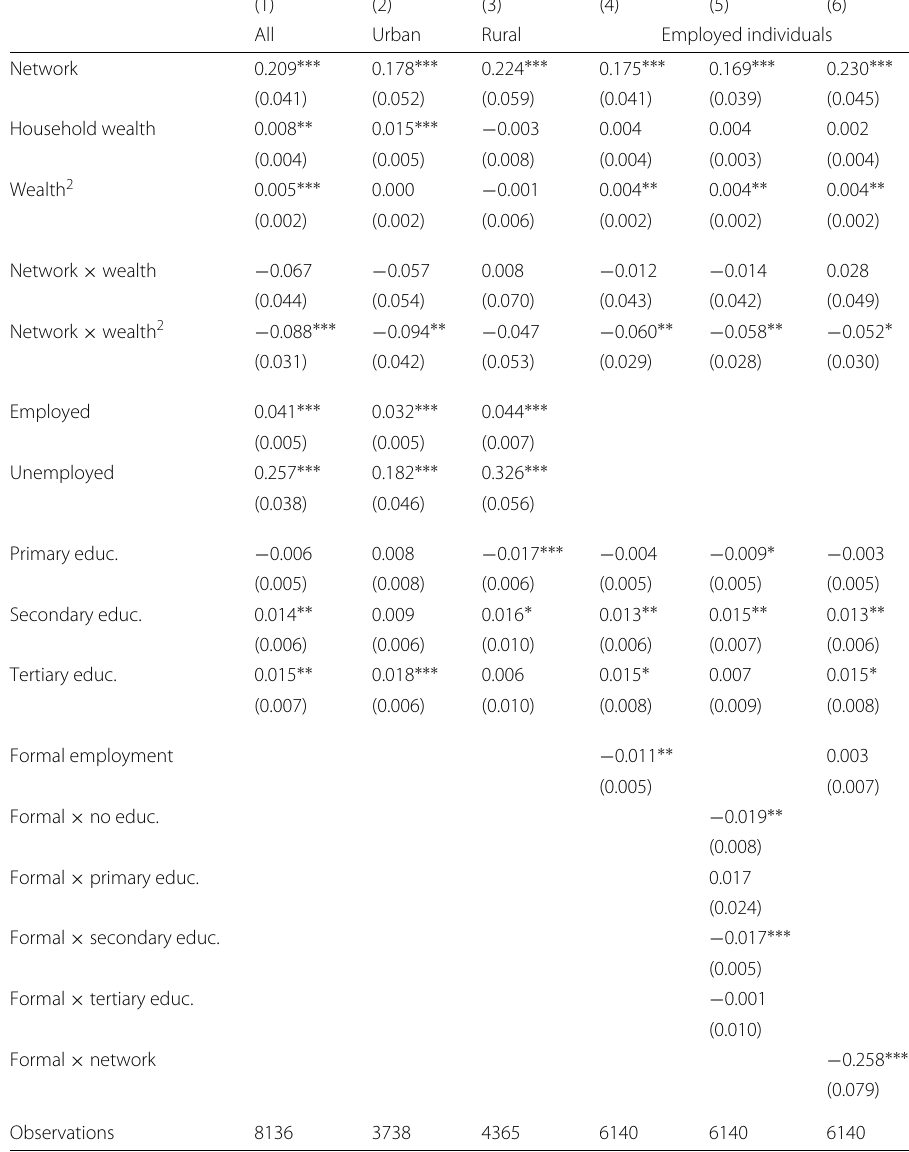
Table 13 Individual determinants of emigration: Labor market factors (1) (2) (3) (4) (5) (6) All Urban Rural Employed individuals Network 0.209 ∗∗∗ 0.178 ∗∗∗ 0.224 ∗∗∗ 0.175 ∗∗∗ 0.169 ∗∗∗ 0.230 ∗∗∗ (0.041) (0.052) (0.045) Household wealth 0.008 ∗∗ 0.015 ∗∗∗ Wealth 2 0.005 ∗∗∗ 0.000 − 0.001 0.004 ∗∗